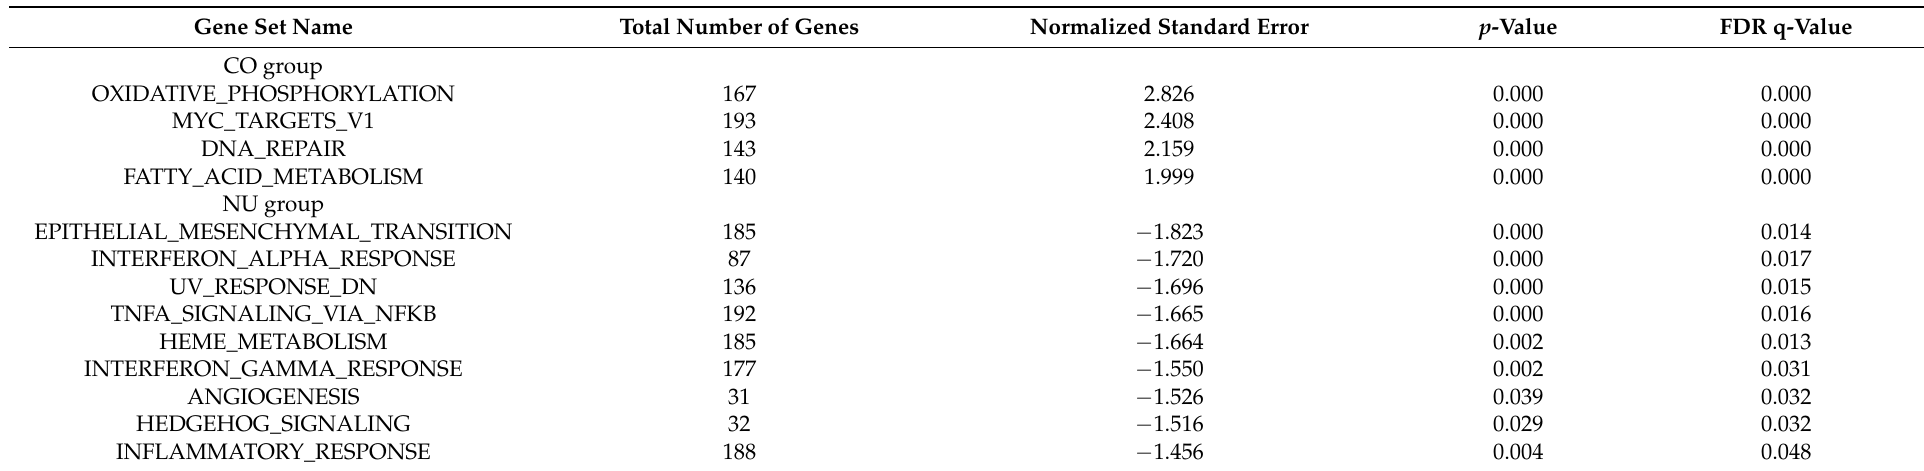
Table 5. Significantly enriched gene groups in PB, respectively, for CO and NU groups, according to Table